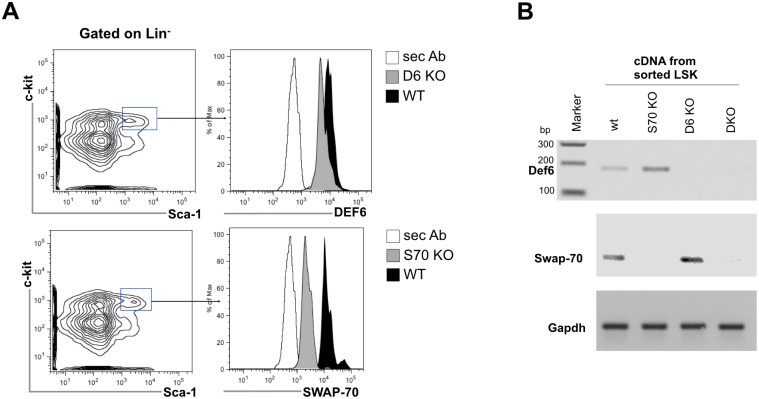
SWAP-70 and DEF6 expression analysis in hematopoietic stem/progenitor cells.(A) Intracellular FACS staining for DEF6 (upper dot plots) and SWAP-70 (lower dot plots) in BM cells. Left: lineage-negative cells, right: HSCs and early progenitors, subgated Lin-c-kit+Sca-1+. Data shown are representative of two independent experiments. (B) mRNA expression analysis of Def6 (product: 176 bp) in sorted LSK cells from wild type (WT), SWAP-70-/-(S70 KO, Def6-/-(D6 KO) and SWAP-70-/-Def6-/- (DKO) mice. Gapdh (product: 100 bp) and an unspecific PCR product (380 bp) served as controls.